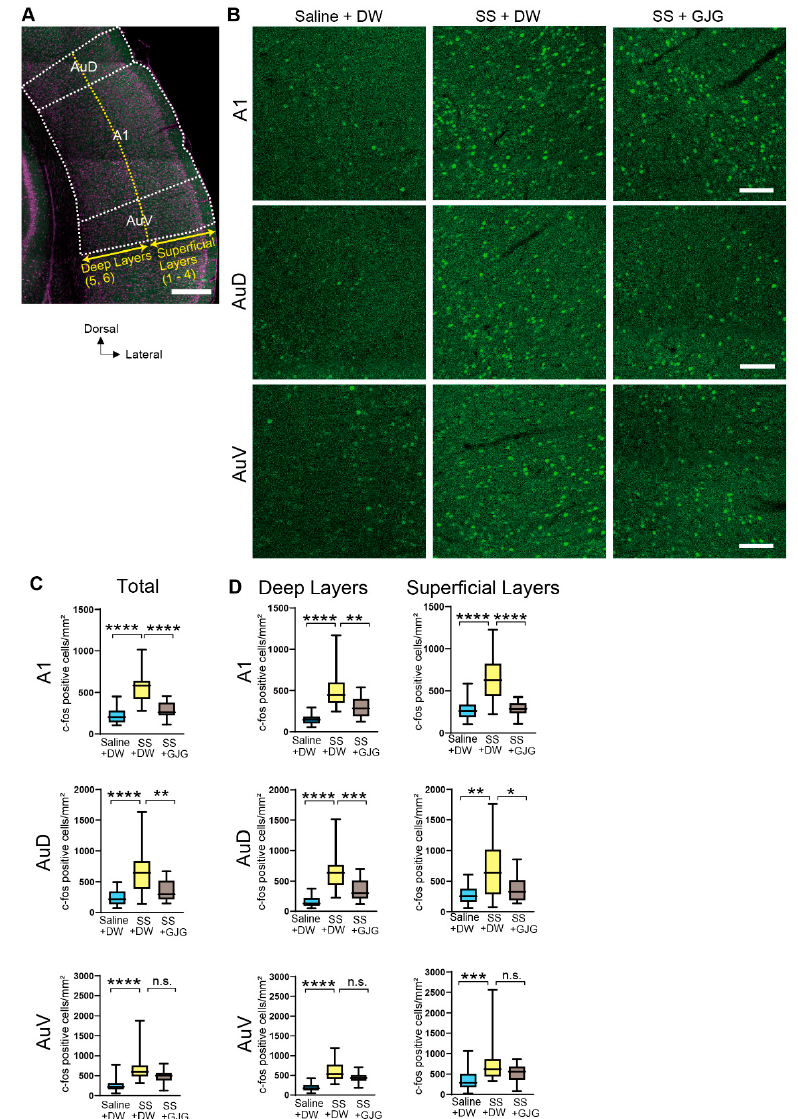
Figure 4. Effect of goshajinkigan (GJG) administration on c-Fos expression in the auditory cortex of salicylate-treated rats. ( A ) A low magnification fluorescent photomicrograph of the auditory cortex. The primary (A1) and dorsal (AuD) and ventral (AuV) secondary auditory cortexes were separated based on Nissl staining (shown in magenta). Layers 1–4 and 5–6 were defined as superficial and deep layers, respectively (yellow dotted lines). Scale bar = 500 µm. ( B ) Fluorescent photomicrographs in the areas of the A1, AuD, and AuV. Green dots show c-Fos-expressing cells in the Saline + distilled water (DW) group (left), sodium salicylate (SS) + DW group (center), and SS + GJG group (right). Scale bars = 100 µm. ( C ) Comparison of the numbers of c-Fos-expressing cells in the Saline + DW, SS + DW, and SS + GJG groups. In the A1 and AuD, cell numbers in the SS + DW group were significantly higher than those in the Saline + DW and SS + GJG groups. In the AuV, the number in the SS + DW group was significantly higher than the number in the Saline + DW group. ( D ) Comparison of the numbers of c-Fos-expressing cells in the superficial and deep layers. In both superficial and deep layers of the A1 and AuD, the numbers in the SS + DW group were significantly higher than those in the Saline + DW and SS + GJG groups. In the superficial and deep layers of the AuV, the numbers in the SS + DW group were significantly higher than those in the Saline + DW group. Data are presented as median (interquartile range) and are analyzed using the Mann–Whitney U test, n = 6 in each group. Asterisks indicate a significant difference between groups (* p < 0.05; ** p < 0.01; *** p <0.001; **** p